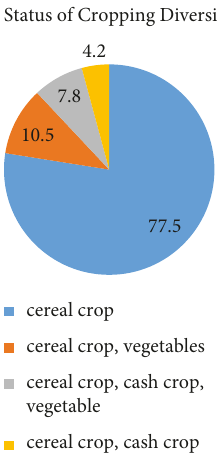
Figure 6: Cropping diversity in the study